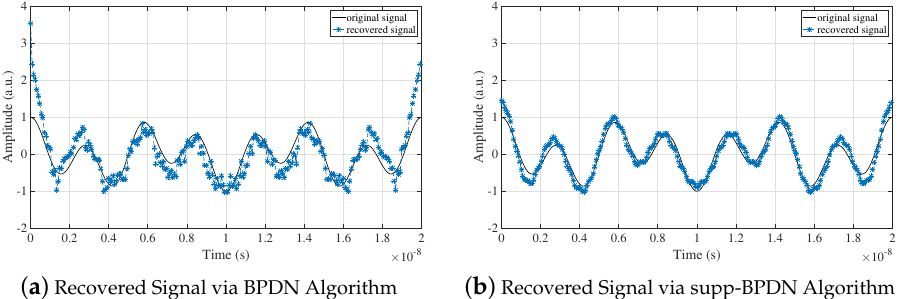
Figure 7. Comparison of original and reconstructed signals under BPDN and supp-BPDN algorithms. Frequencies of signal were 350 MHz and 150 MHz; sampling rate was 200 MHz. ( a ) Signal recovered by BPDN. ( b ) Signal recovered by supp-BPDN.